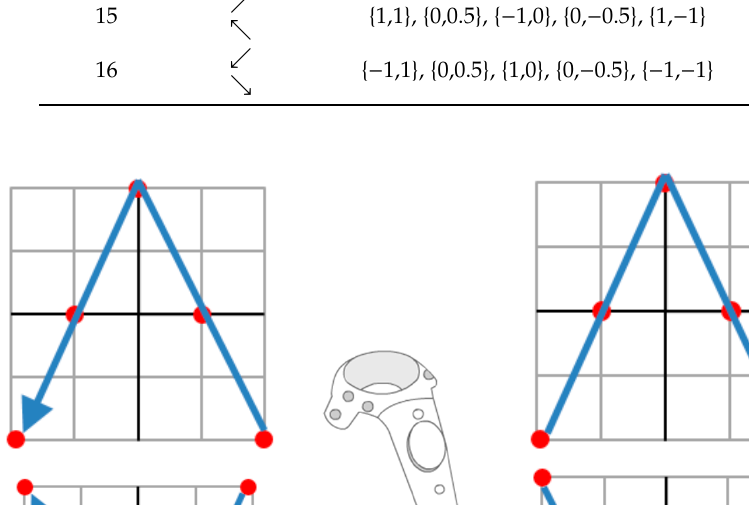
Figure 8. Eight recognition targets.